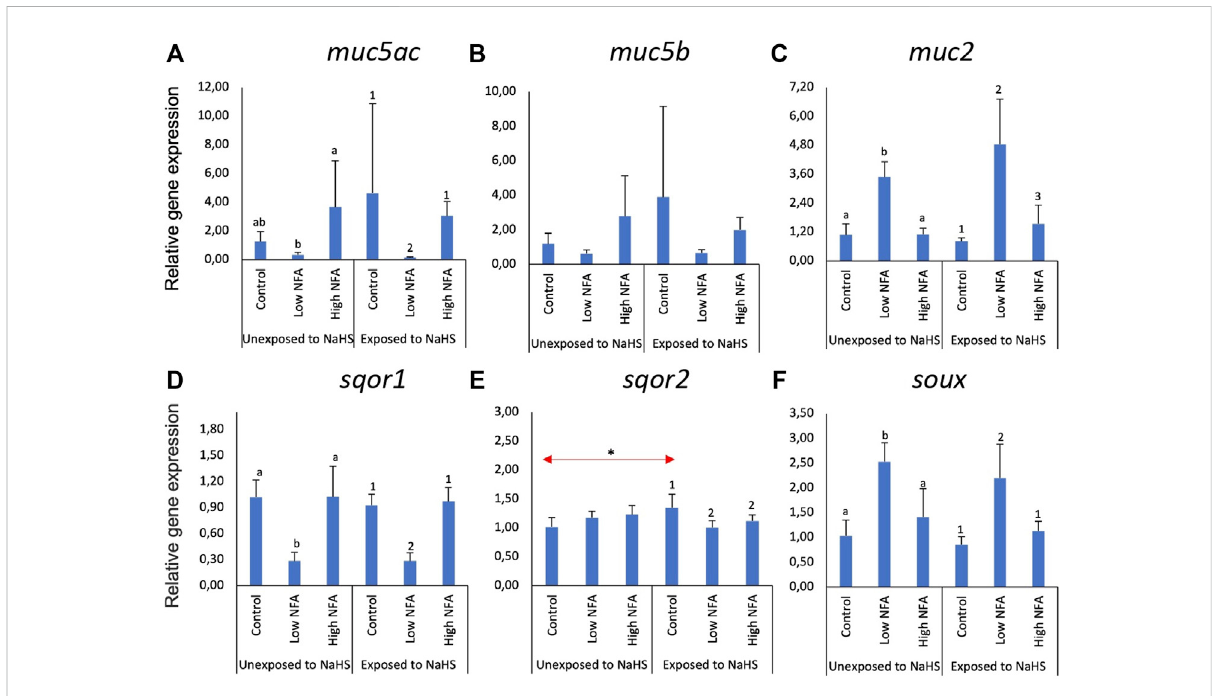
FIGURE 2 Relative gene expression of mucin genes (A – C) and sulphide-detoxi fi cation genes (D – F) in the gill explants treated with a mucus inhibitor Ni fl umic acid (NFA) with and without the NaHS exposure. The bars indicate mean and standard deviation of four individual fi sh (n = 4). Statistically signi fi cant differences ( p -value < 0.05) within unexposed to NaHS are denoted with letters, while numeric marks denote the differences within exposed to NaHS. Red arrows indicate signi fi cant differences in NaHS exposure ( p -value <